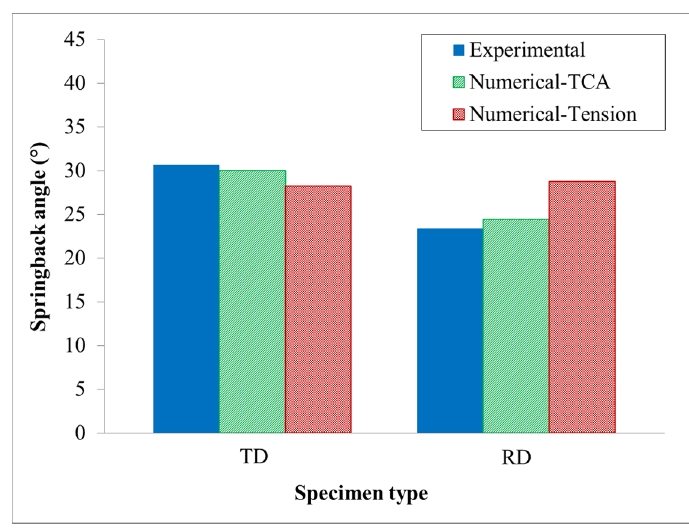
Figure 13. Comparison of experimental and numerical springback in V-bending.